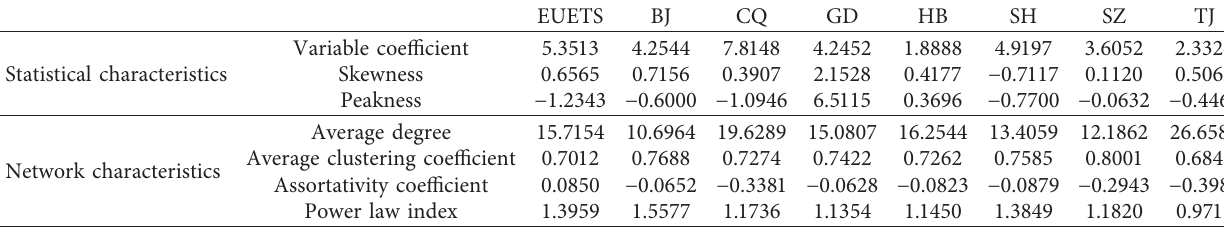
Table 2: Statistical characteristics and network topological